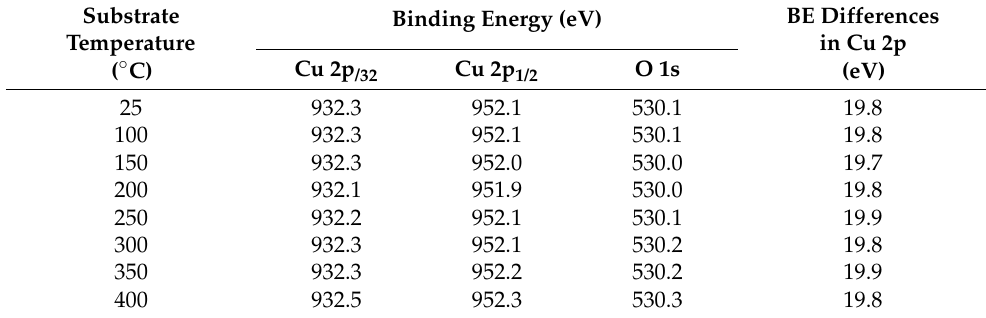
Table 2. XPS analysis results for Cu 2 O thin films deposited at various substrate temperatures.